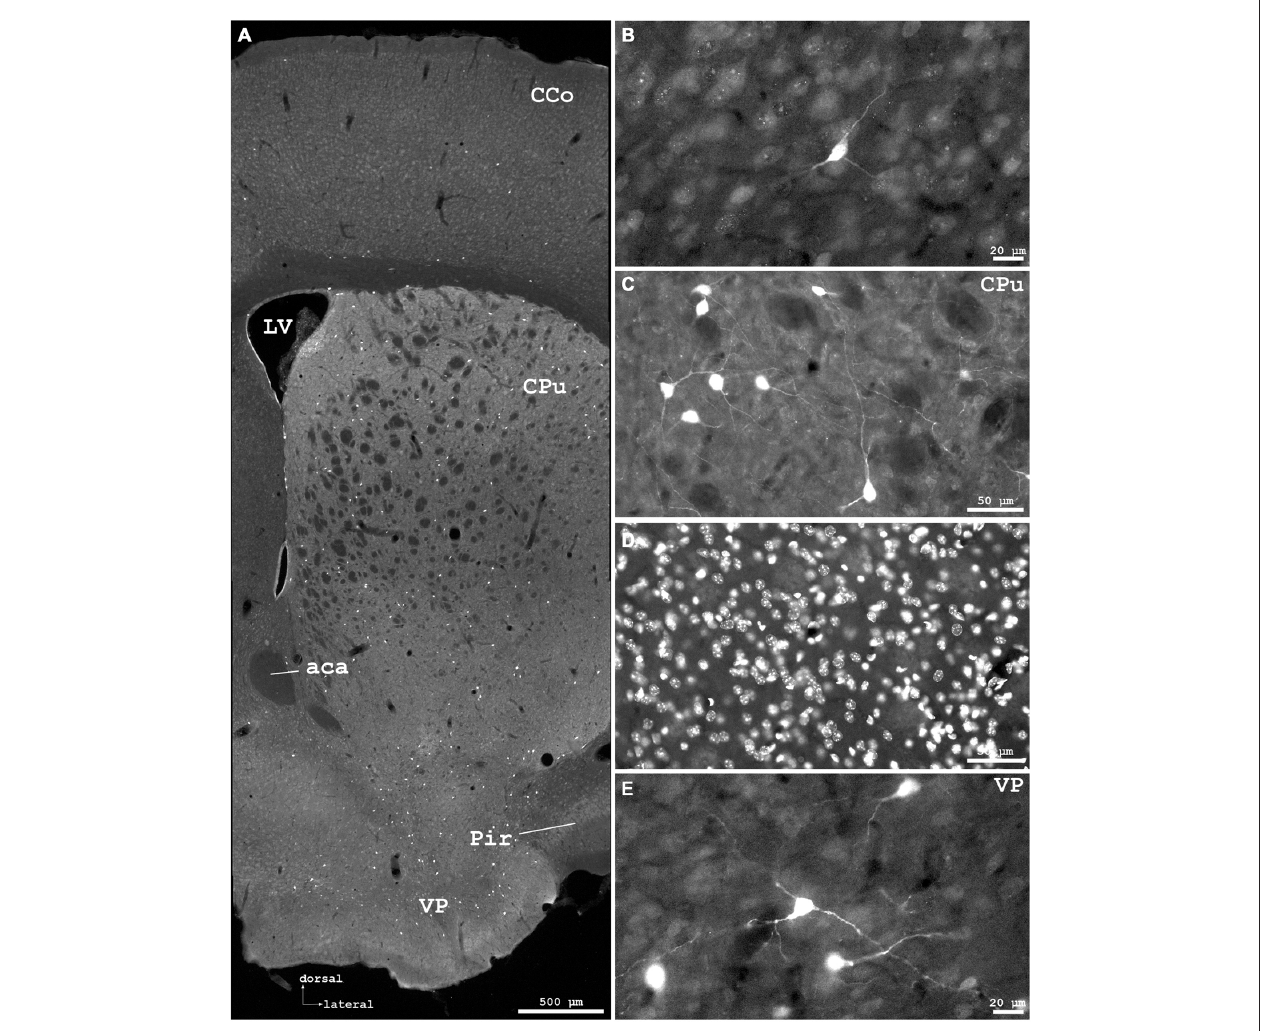
FIGURE 2 | Cygb-immunofluorescence in a frontal section of the mouse brain at the level of approximately interaural +4.3 mm, corresponding to Figure 27 of the mouse brain atlas. (A) Low power photomicrograph (MIA) showing primary motor and somatosensory regions of the CCo, lateral ventricle (LV), striatum (Ncl. caudatus/putamen, CPu) and ventral pallidum (VP). (B) Higher magnification demonstrating Cygb-IR neuron in lamina IV of S1 cortex, (C) Multipolar neurons in the lateral striatum, (D) DAPI nuclear staining of the same sector, and (E) multipolar neurons with long processes in the VP. Abbreviation: ACA, anterior part of the anterior commissure; Pir, piriform